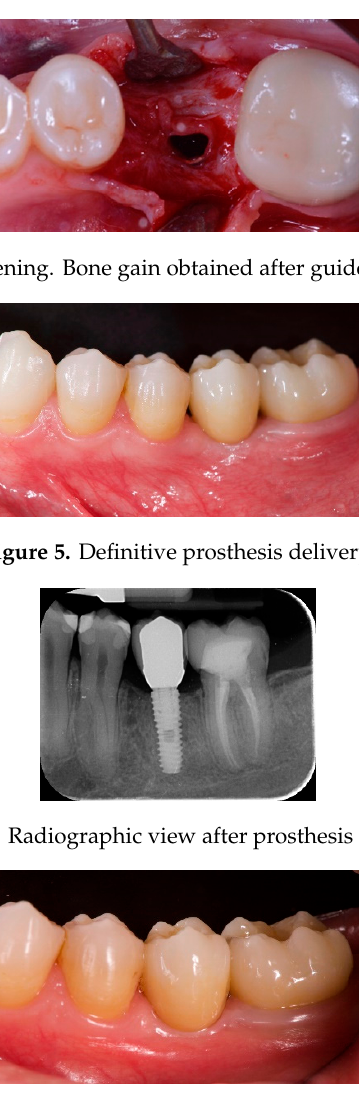
Figure 7. 18 months clinical follow-up.